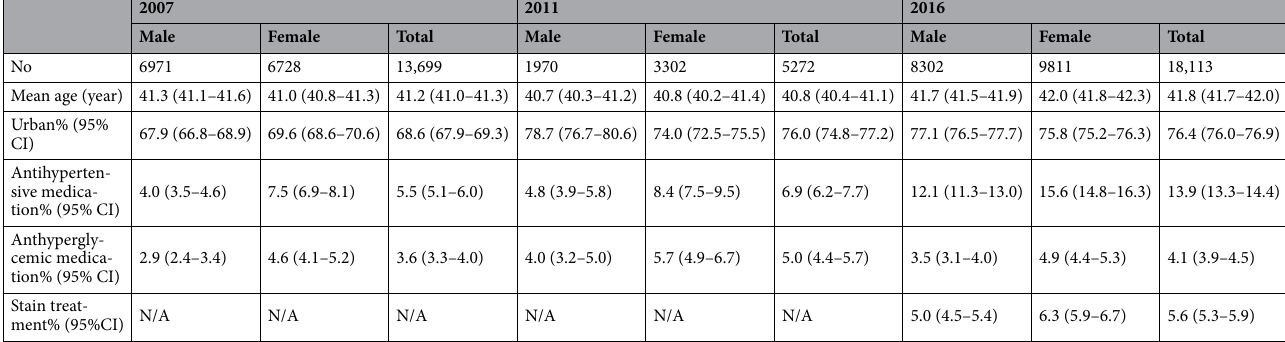
Table 2. Demographic characteristics of the Iranian adult population in STEPS 2007–2016. STEPS, STEPwise approach to